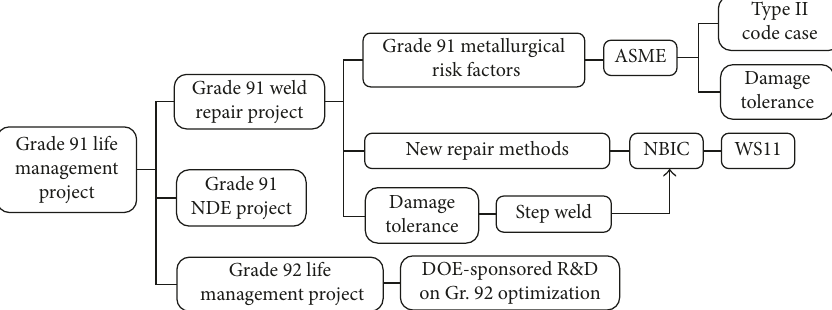
Figure 1: The evolution of major research and development projects specific to 9% Cr creep strength-enhanced ferritic (CSEF) steels within the Electric Power Research Institute since 2007.